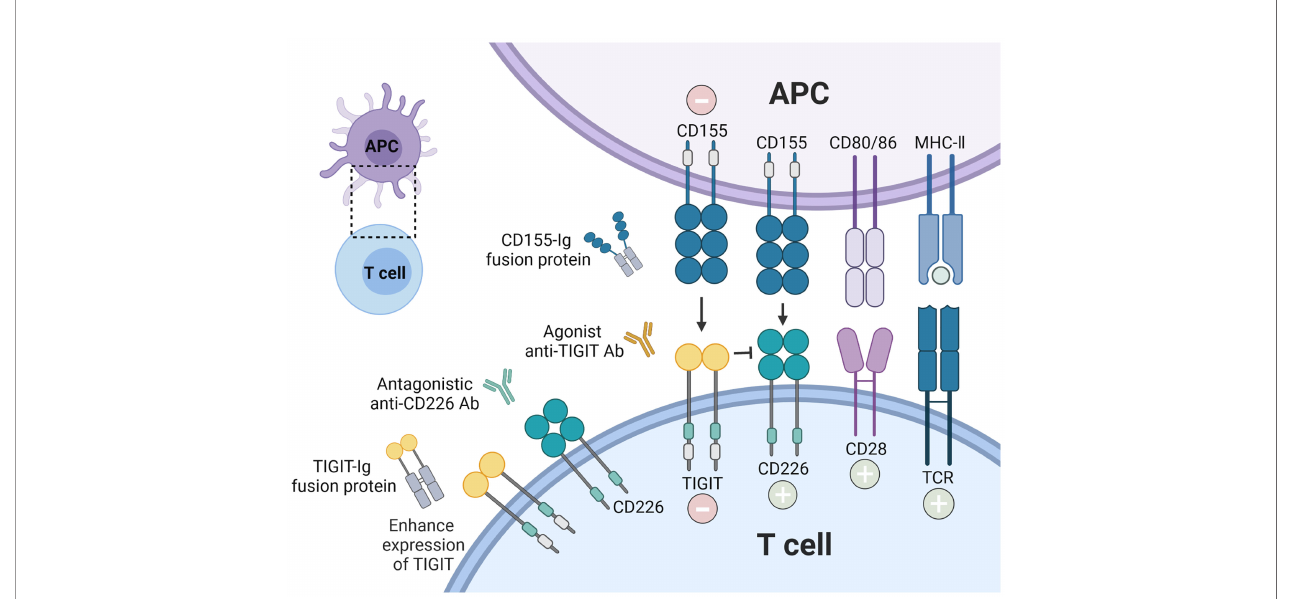
FIGURE 3 | Therapeutic intervention by enforcing CD155-TIGIT axis. The current strategies are being investigated to block autoreactive T cell responses via TIGIT signaling pathway: recombinant TIGIT-Ig fusion protein; TIGIT overexpression; agonist anti-TIGIT Ab, and recombinant CD155. In addition, antagonistic anti-CD226 Ab could also inhibit the stimulatory function of T cells.